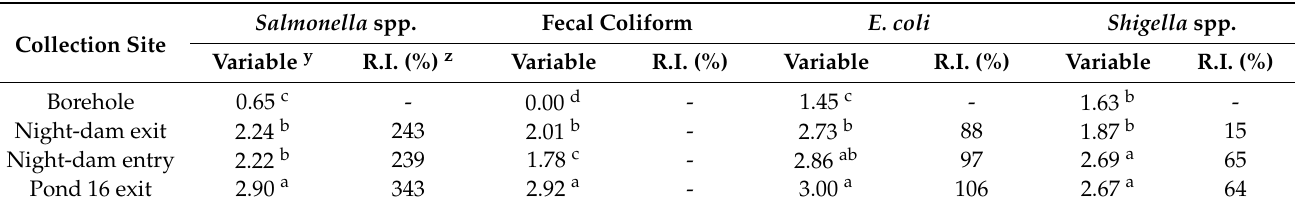
Table 1. Log-transformed mean counts of Salmonella spp., Shigella spp., Escherichia coli , and fecal coliform in treated wastewater relative to that from borehole water used for irrigation of various